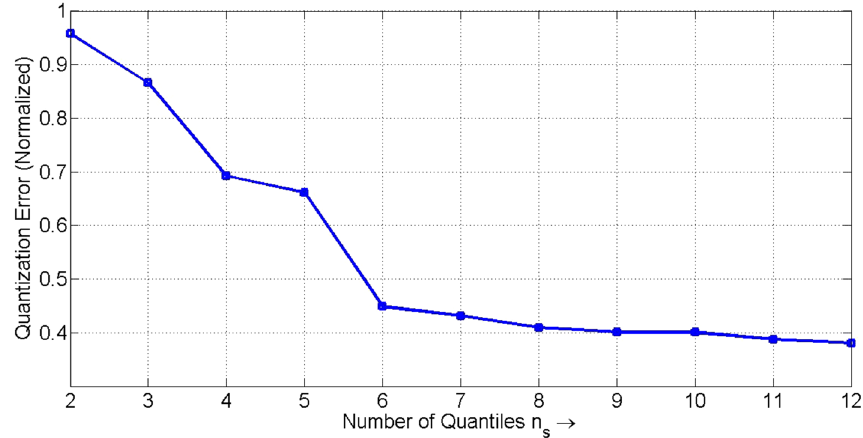
Figure 3. Normalized quantization error for different values of n s